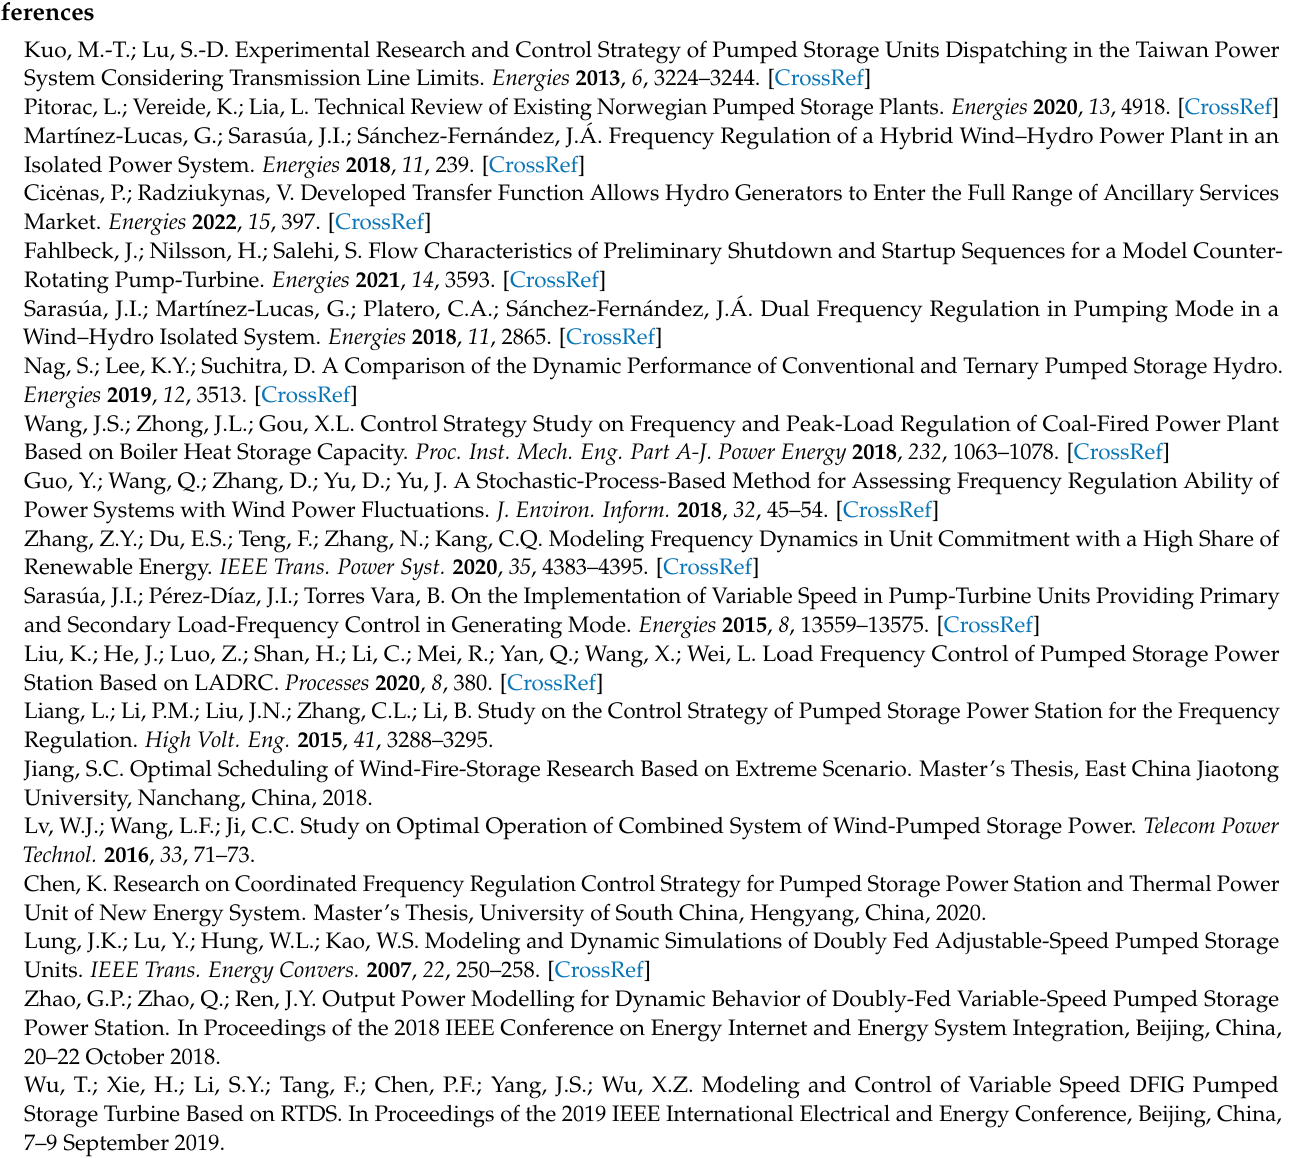
sidering the lowest total system operating cost and optimal time as the objectives. The simulation results show that the joint frequency regulation strategy is of great significance for the improvement of the unit frequency regulation